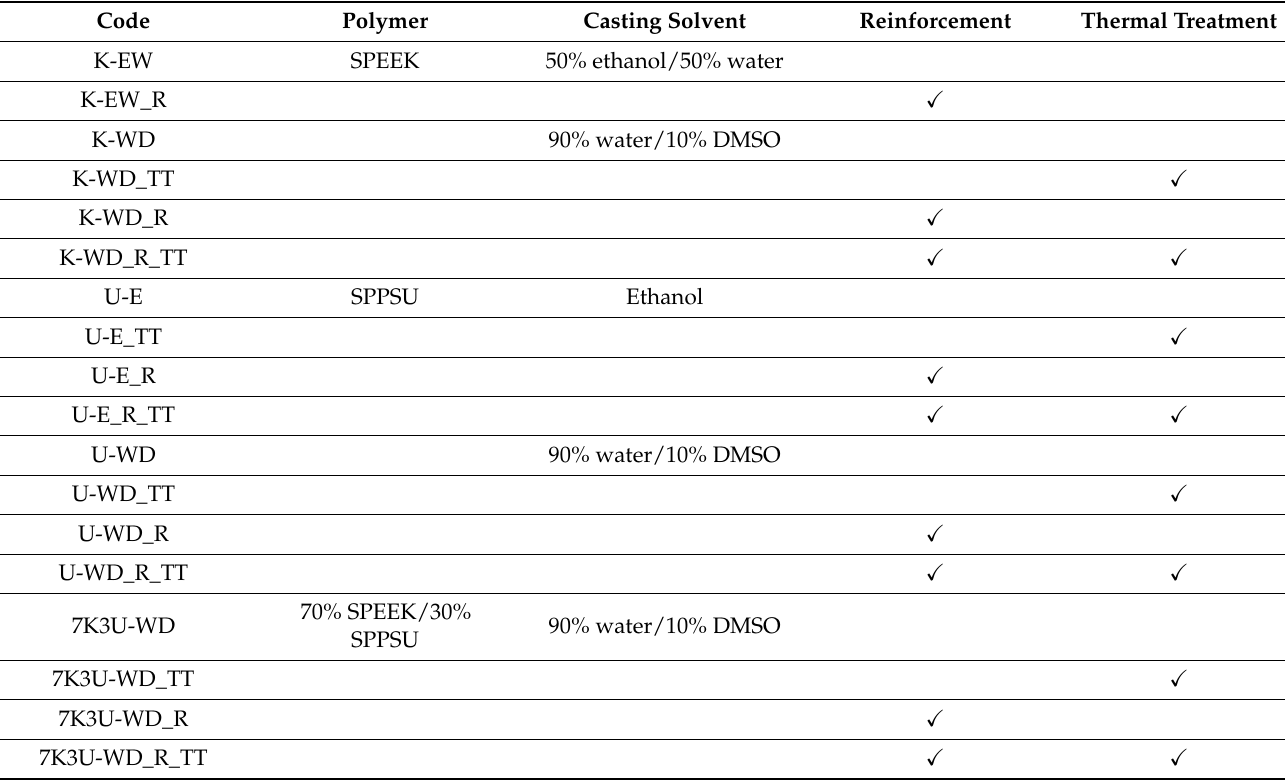
Table 1. List of casted